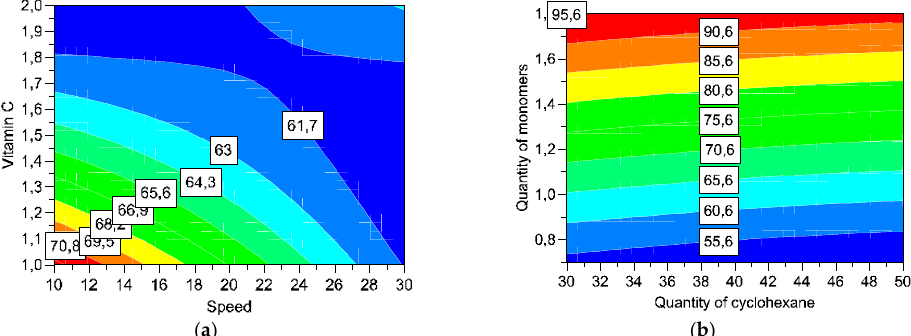
Figure 7. Response surfaces for encapsulation efficiency by varying speed and vitamin C ( a ) and quantities of cyclohexane and monomers ( b ).